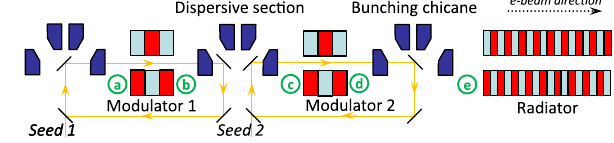
FIG. 5. Layout for the EEHG setup. Here, only one radiator is needed.